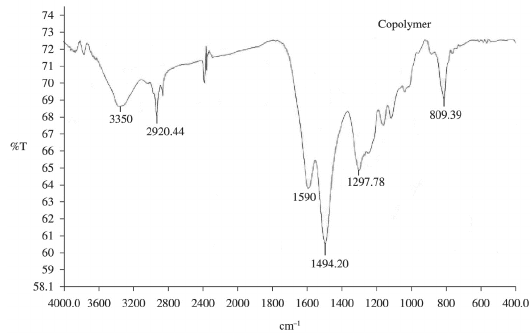
Figure 1. FTIR spectrum of poly (aniline-co-o-toludine) copolymer.